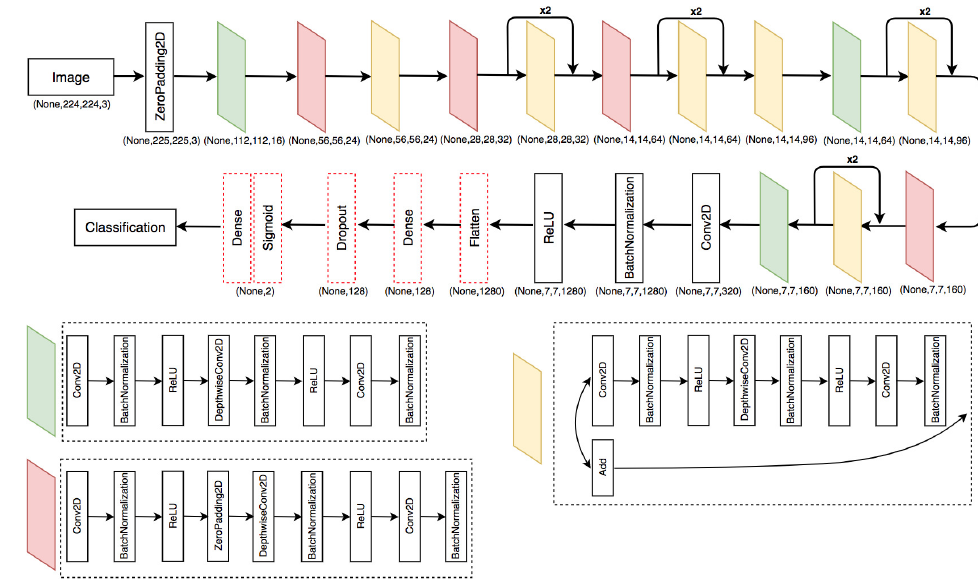
Figure 11. The network architecture of the proposed method 2 developed from MobileNet-v2.